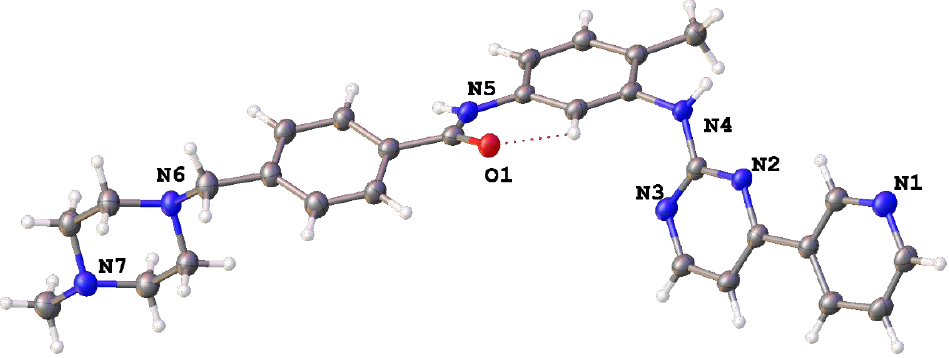
Figure 2. Molecular view of Imatinib in representation of atoms with thermal ellipsoids (p = 50%).